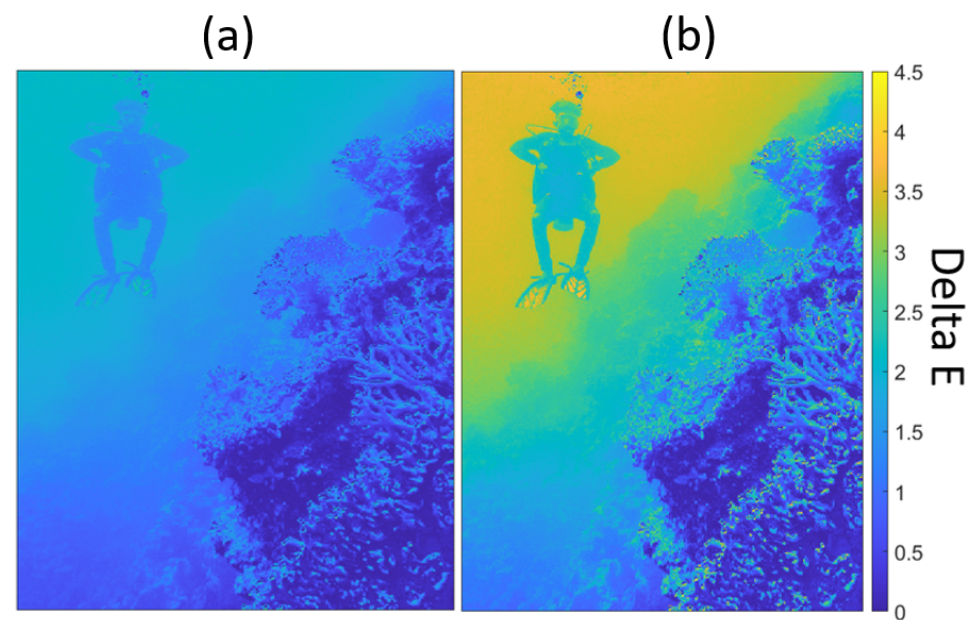
Figure 9. Error image for ( a ) 2-layer TM-Net. ( b ) CLHE limited to 2 iterations.